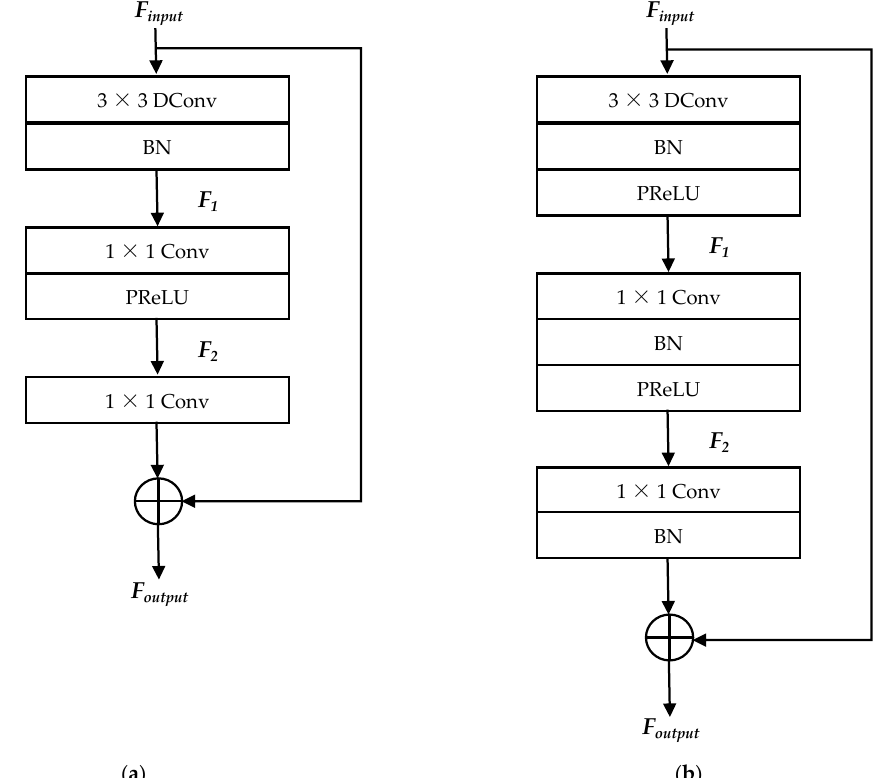
Figure 6. Building blocks with different amounts of batch normalisations and activation functions. ( a ) ECN block with one batch normalisation and one PReLU activation. ( b ) ECN block with three batch normalisations and two PReLU